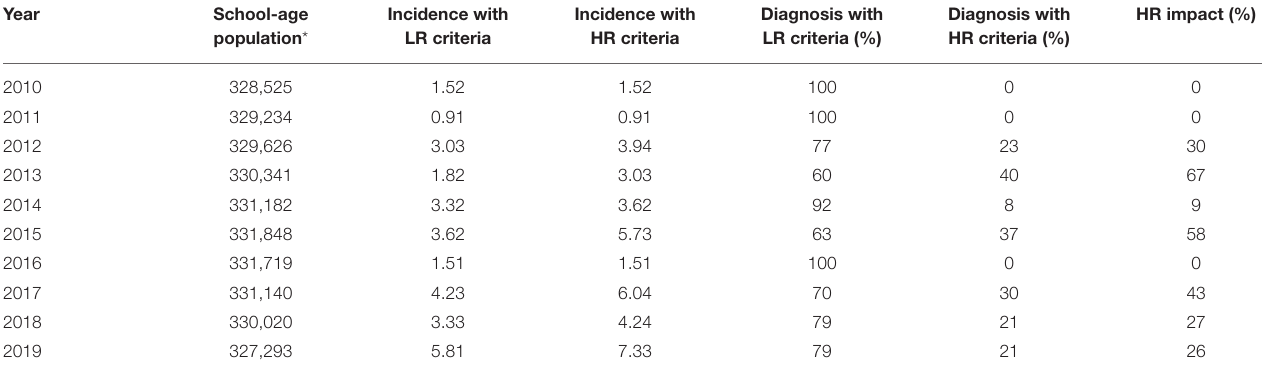
* Population at risk data derived by ISTAT